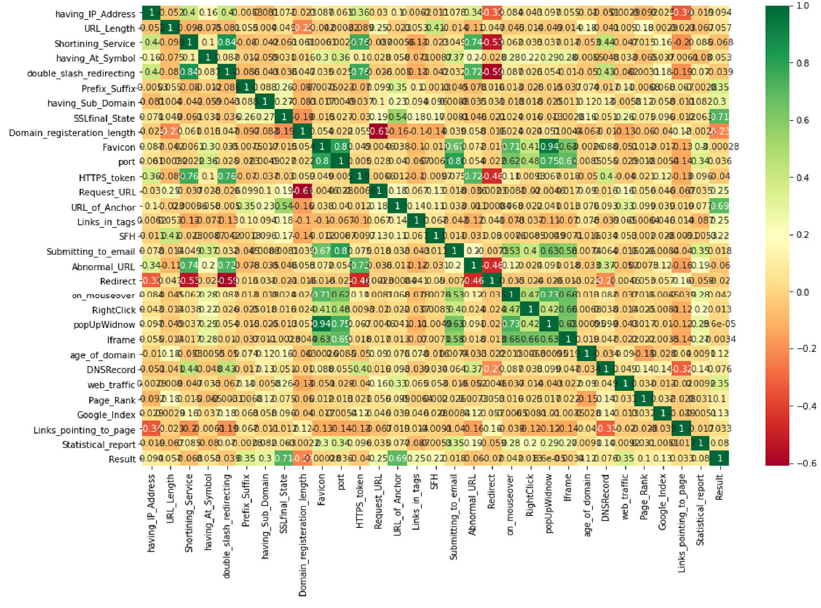
Fig. 5. Heatmap to identify which features are most related to the result